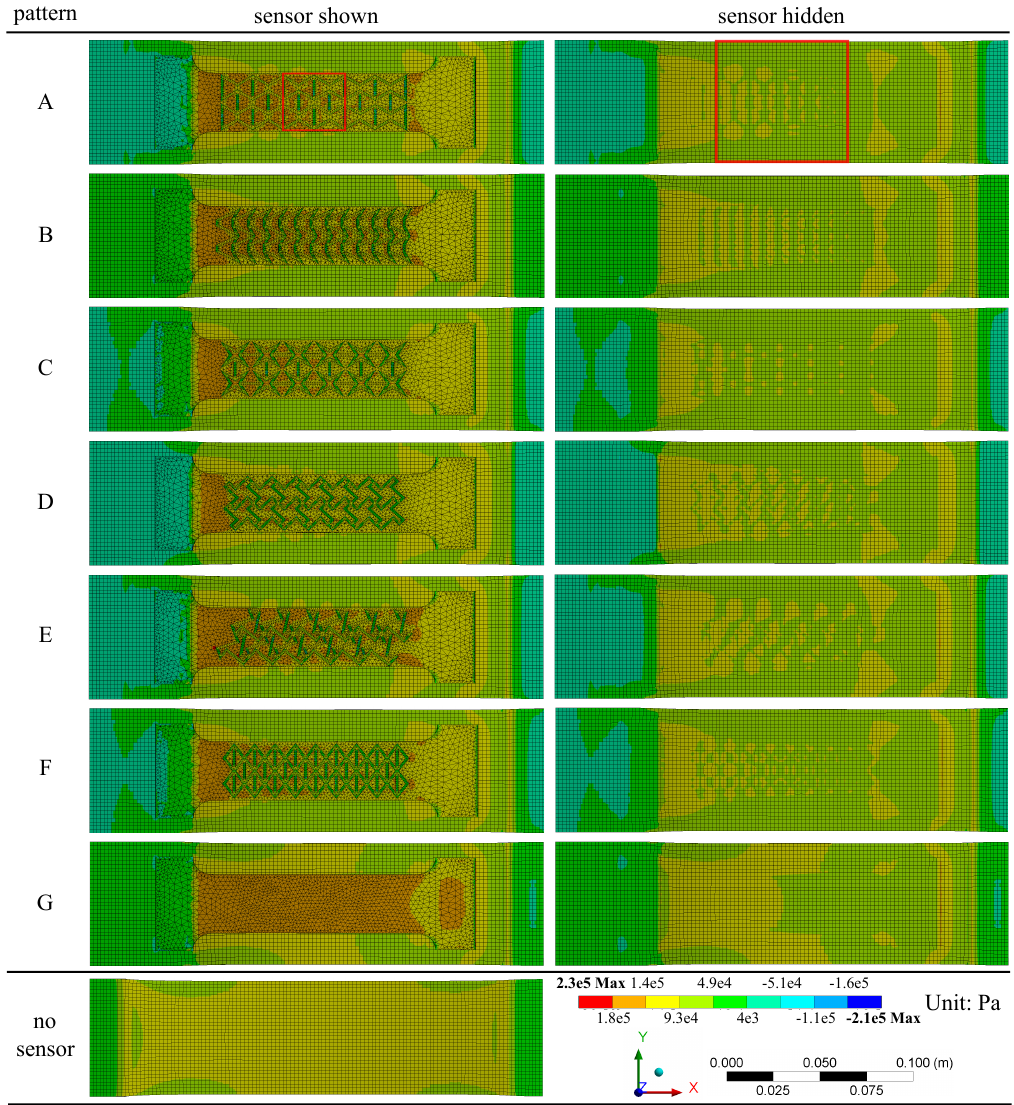
Figure 9. Simulated axial stress distributions for fully attached canine skin model under different patterns at 5% strain, including the pure-skin configuration (no